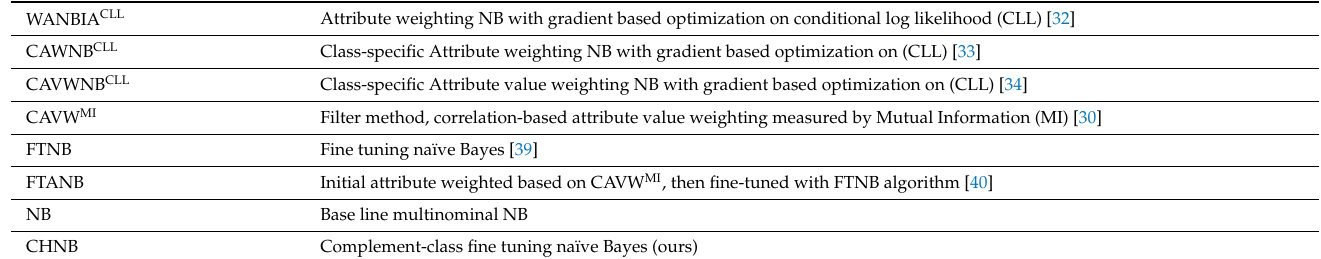
Table 1. Description of the competitors’ NB classifiers.